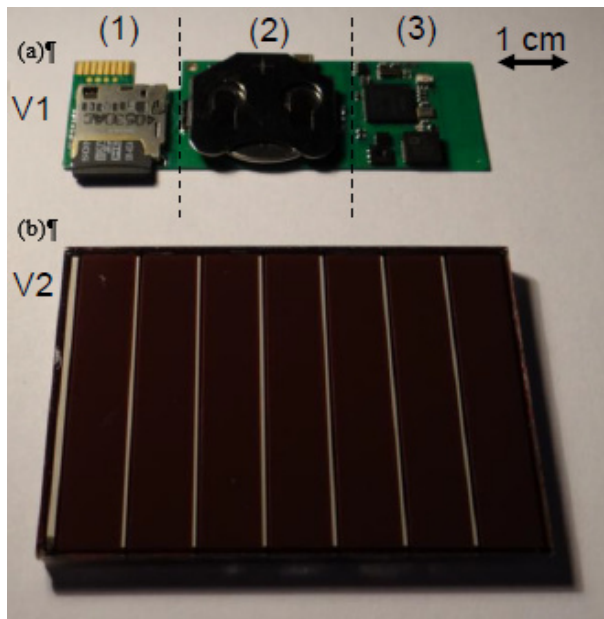
Figure 4. (a) Battery-powered platform (with storage memory). (b) Autonomous platform (with solar